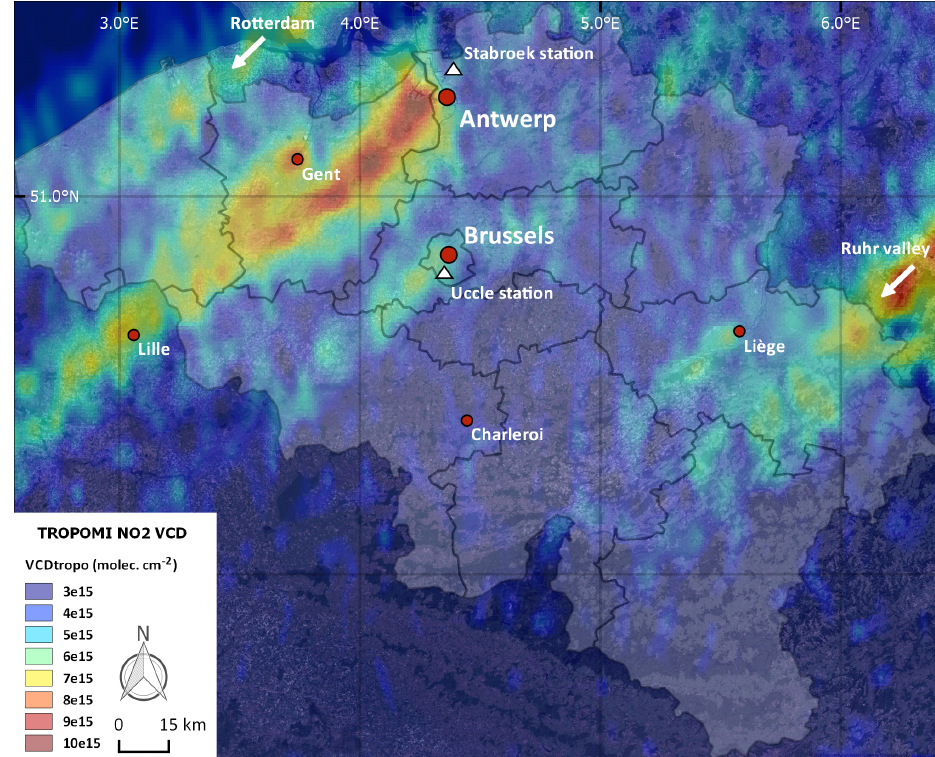
Figure 1. Tropospheric NO 2 hotspots observed over Belgium by TROPOMI, based on an early afternoon S-5P orbit (8826) on 27 June 2019 (OFFL v1.03.01 – thin plate spline interpolation at 0.01 ◦ ) (© Google Maps). Red markers indicate the five largest Belgian cities, as well as the city of Lille, France, which is a major NO 2 source close to the Belgian border. The white triangles indicate the locations of the Uccle station (50.8 ◦ N, 4.4 ◦ E; 100ma . s . l . ) and Stabroek station (51.3 ◦ N, 4.4 ◦ E; 4ma . s . l . ). White arrows indicate the source locations